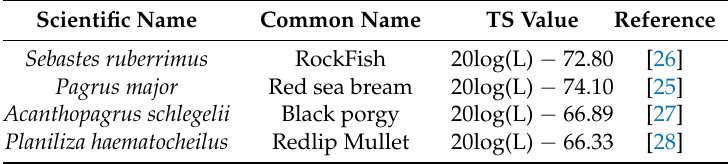
Table 2. Target strength (TS) at 200 KHz of some common fish farmed in